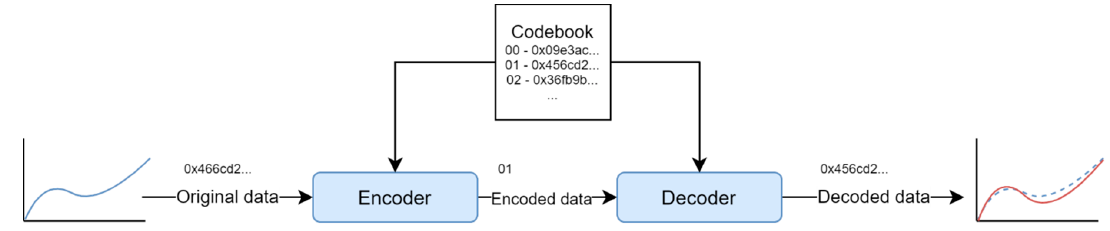
Figure 3. Vector quantisation compression.